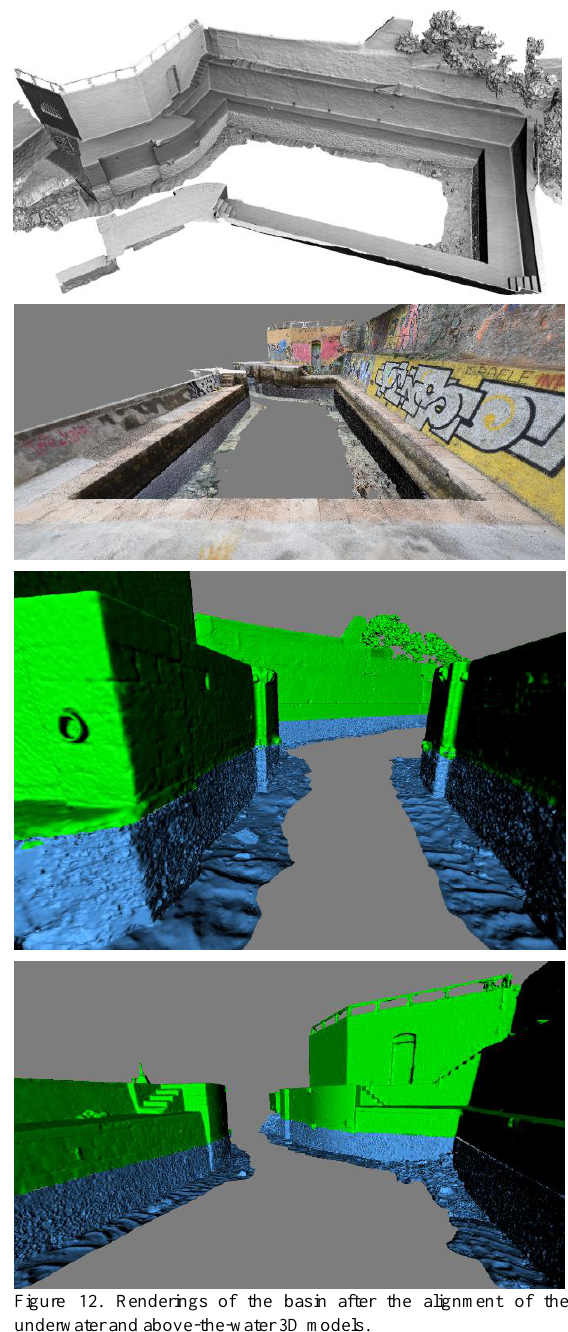
Figure 12. Renderings of the basin after the alignment of the underwater and above-the-water 3D